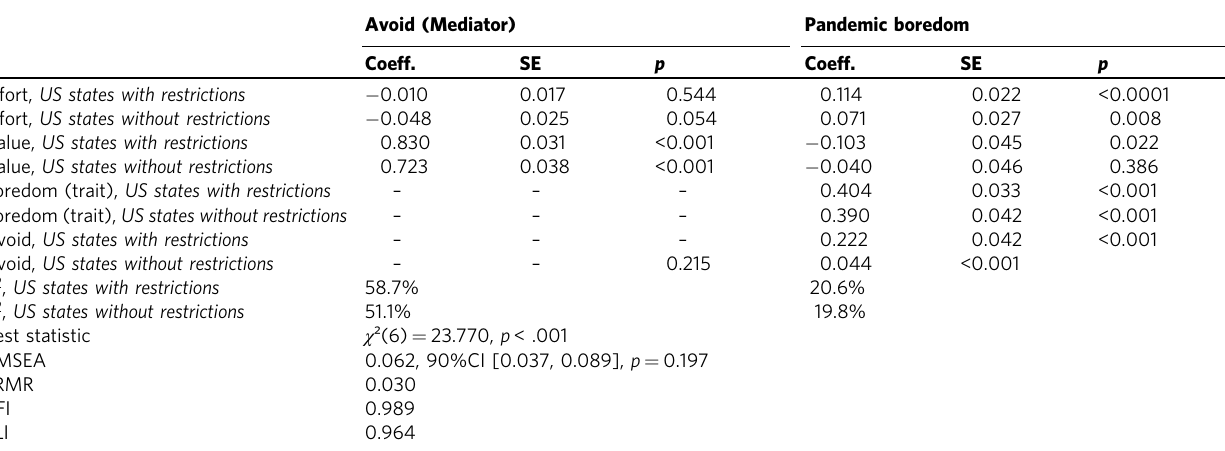
Table 4 Regression coef fi cients, standard errors, and summary information for the thanksgiving model fi tted in US states with restrictions and US states without restrictions (multigroup analysis).